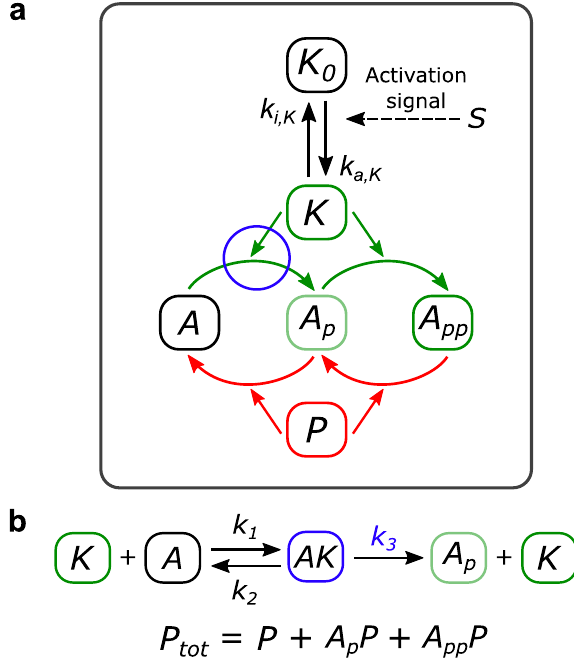
Figure 1. Scheme of the Suwanmajo-Krishnan model, based on their Figure 26 . ( a ) In green, the phosphorylation reactions. In red, the dephosphorylation ones. Each of these reactions involves the association, dissociation, and catalysis of an intermediate complex. The activation and inactivation of the first-level kinase is direct (no intermediate complex). The input is the parameter S, the output A pp . ( b ) Shown for later results: the reactions in the first phosphorylation step and the variables making up the total amount of